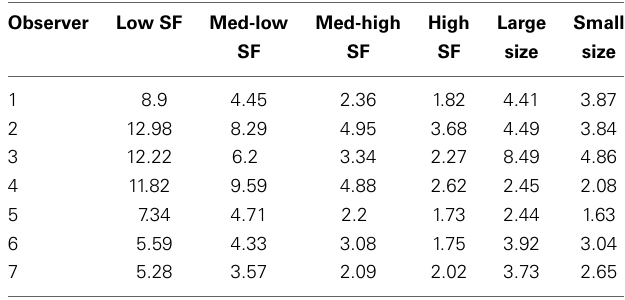
Table 1 | Overview of slope parameter estimates for each subject from the low-level tasks in Experiment 2.